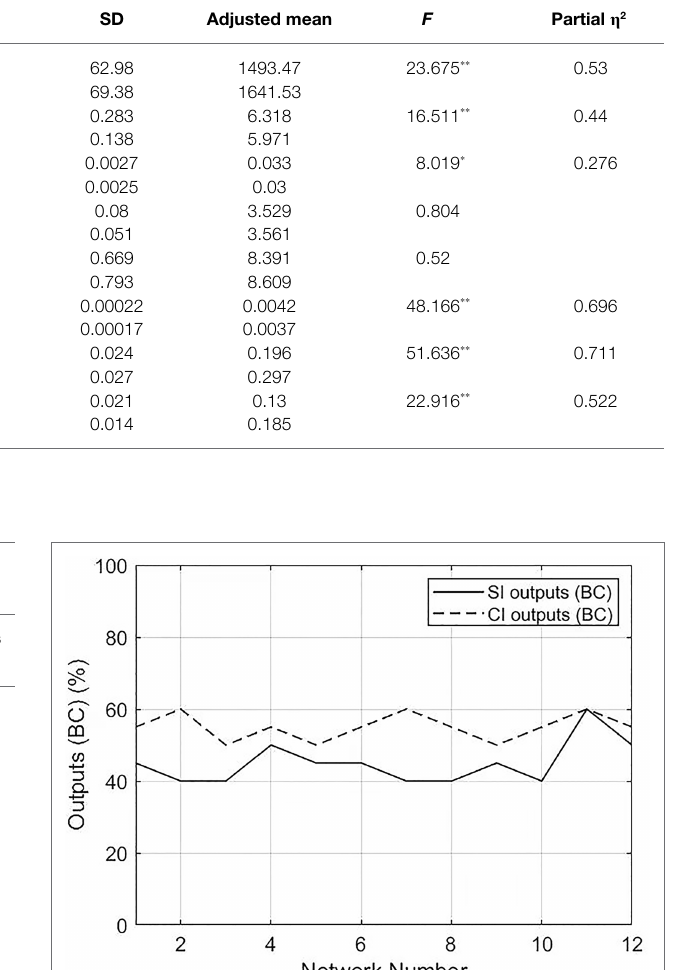
TABLE 5 | Results of ANCOVAs on main parameters of CI and SI output networks. Measures